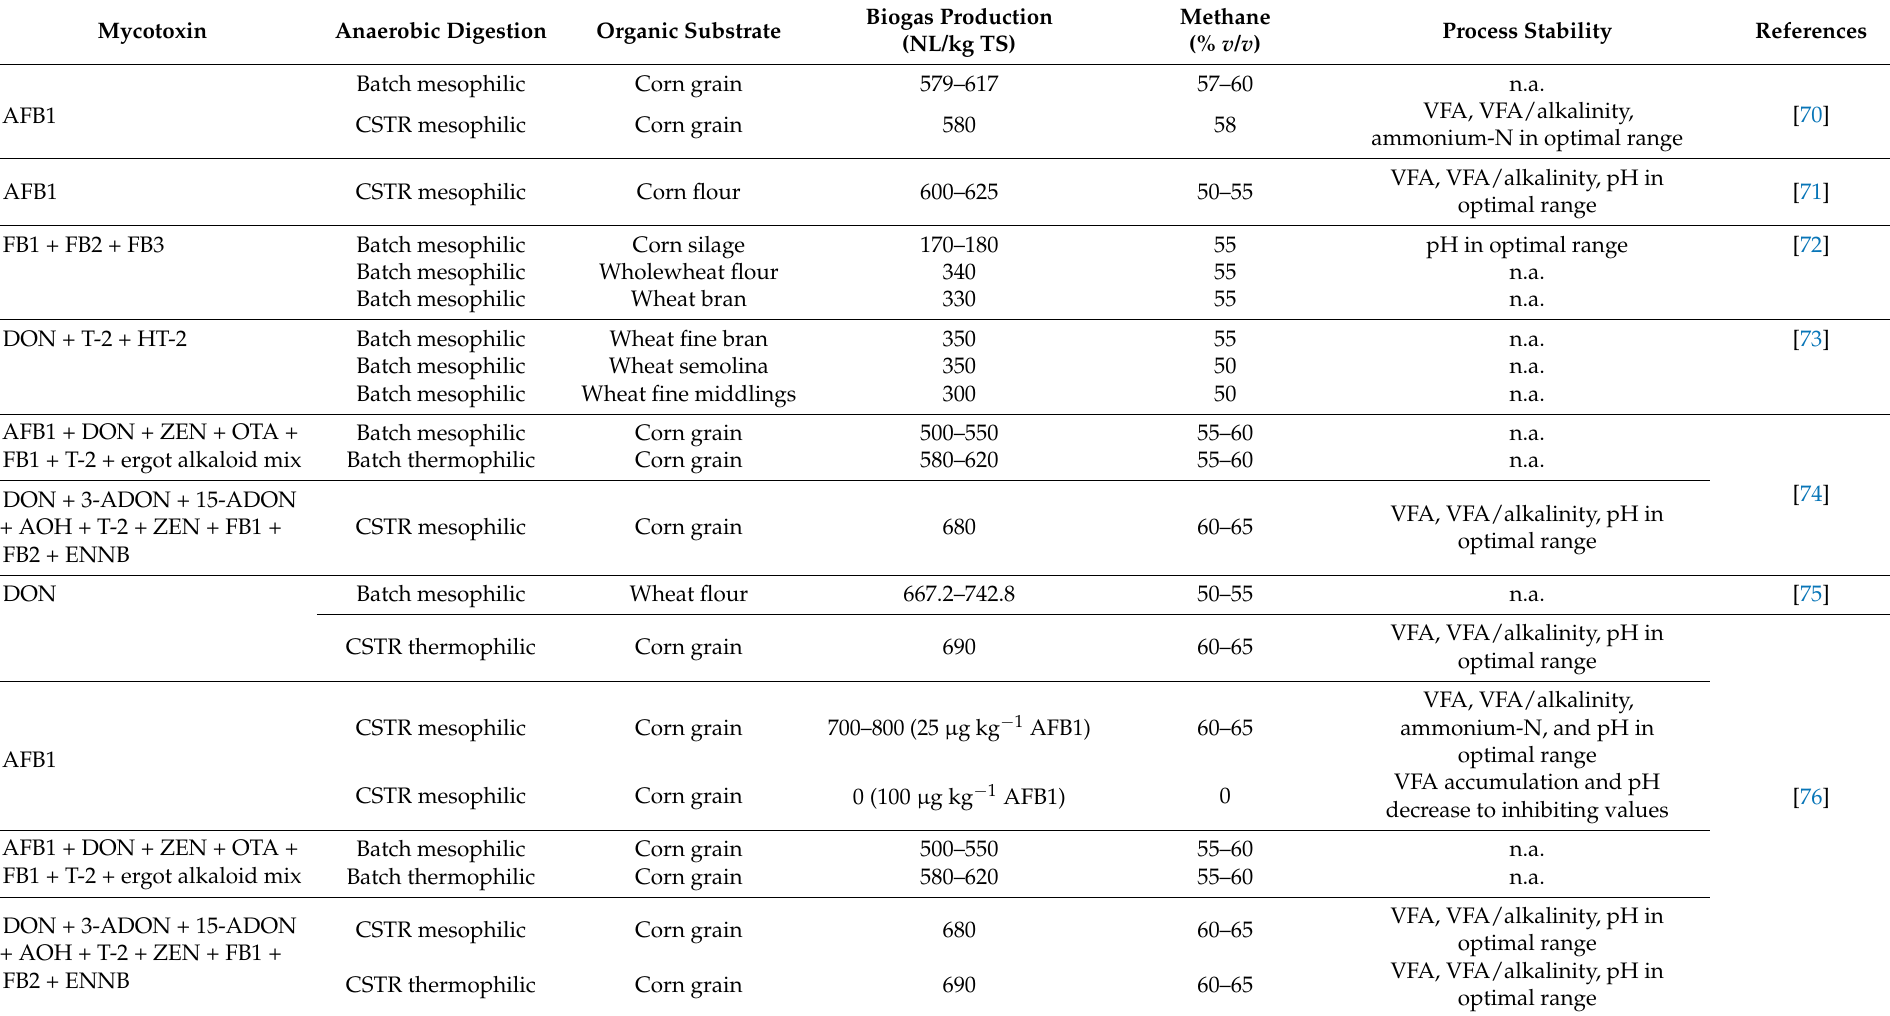
Table 3. Biogas production and process